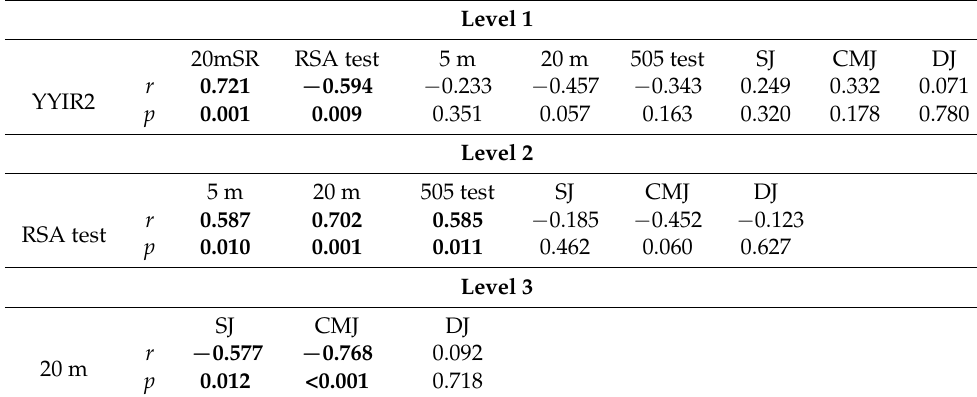
Table 2. The Pearson’s r correlation analysis results.